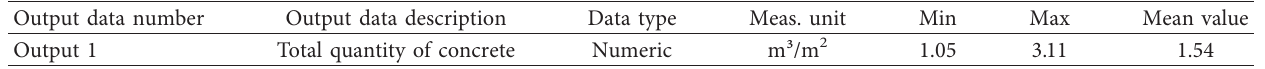
Table 2: Output data of the first model.